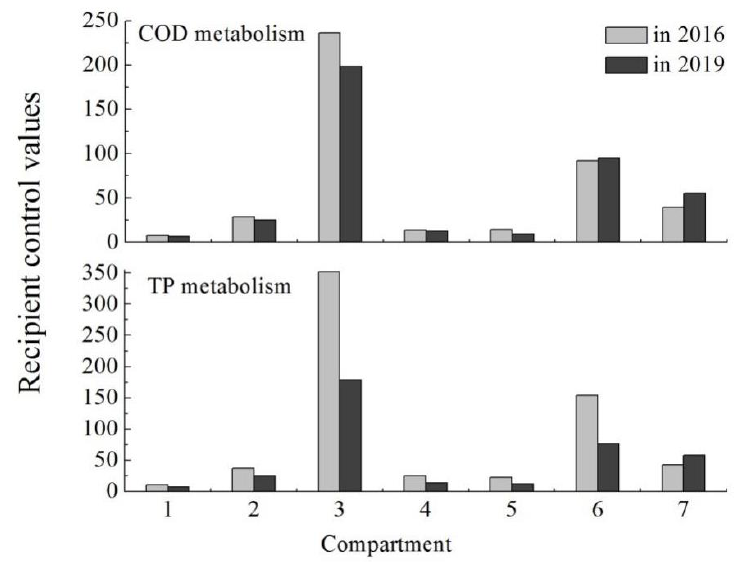
Figure 8. Recipient control values for compartments 1 to 7 controlled by compartments 1 to 19.